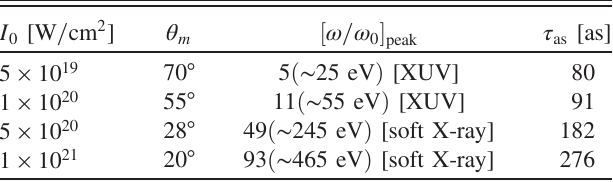
TABLE I. Summary of physical observables determined by using different laser intensities. Table highlights the angles at which maximum energy is radiated ( θ m ), the most prominent harmonics emitted along θ m and the duration of the associated attosecond pulse.